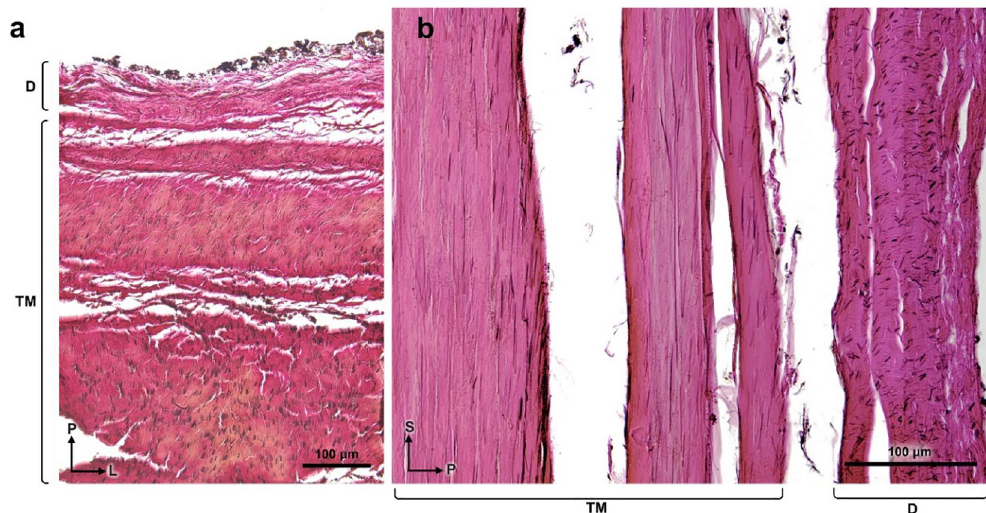
Figure 6. Distribution of elastic fibers in the tectorial membrane (TM) and the dura mater. Verhoeff Van Giseon stain. ( a ) A cross-section of ligamentous tissues is firmly attached to the superior clivus. Longitudinal thick elastic fibers (black spots) are identified in the deep layer of the TM, contrary to the cranial dura mater (D). ( b ) A longitudinal section of ligamentous tissues at the level of the sub-clival region. The spinal dura mater contains horizontal elastic fibers. The TM showed longitudinal elastic fibers (black lines) parallel to the collagen bundles (pink). D dura mater, TM tectorial